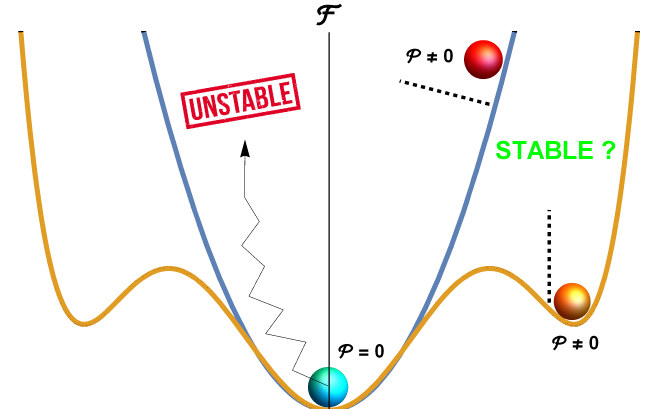
Figure 9: The puzzle of stability for the homogeneous holographic models (axions- like and Q-lattices like) with SSB of translations. The thermodynamically favoured phases with P = 0, which minimize the free energy F , are all unstable! On the contrary, all the phases which do not minimize the free energy do not present any dynamical instability (at least at linear level). Are those phases metastable? Where does the instability of the favoured phases come